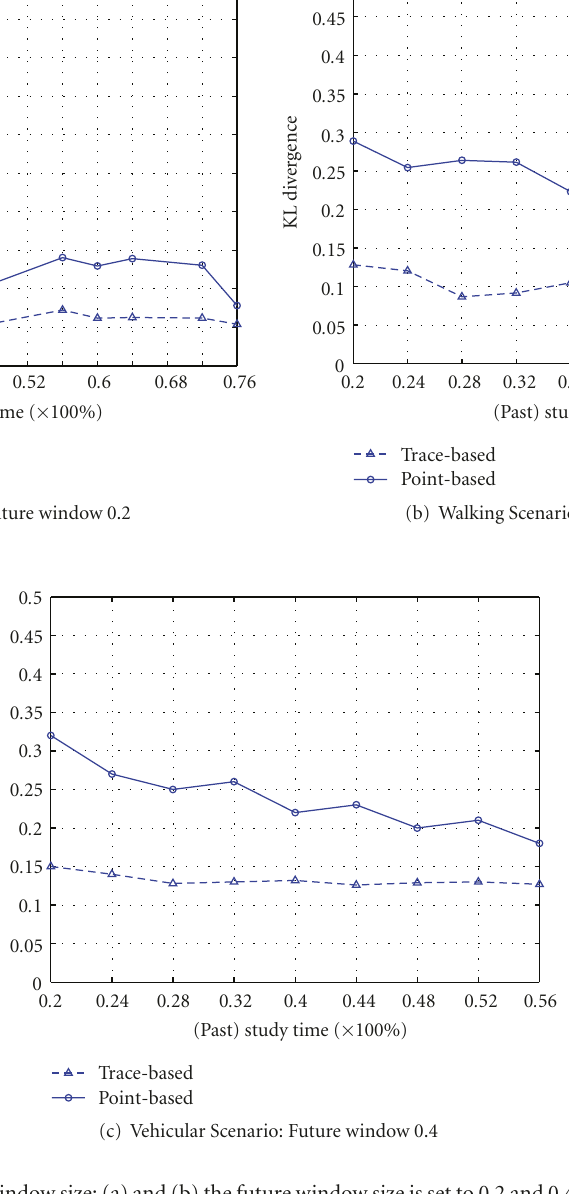
Figure 5: KL-divergence: fixed future window size; (a) and (b) the future window size is set to 0.2 and 0.4 of the total study time, respectively, when the average number of neighbors is 5; (c) the future window size is set to 0.4 of the total study time when the average number of neighbors is